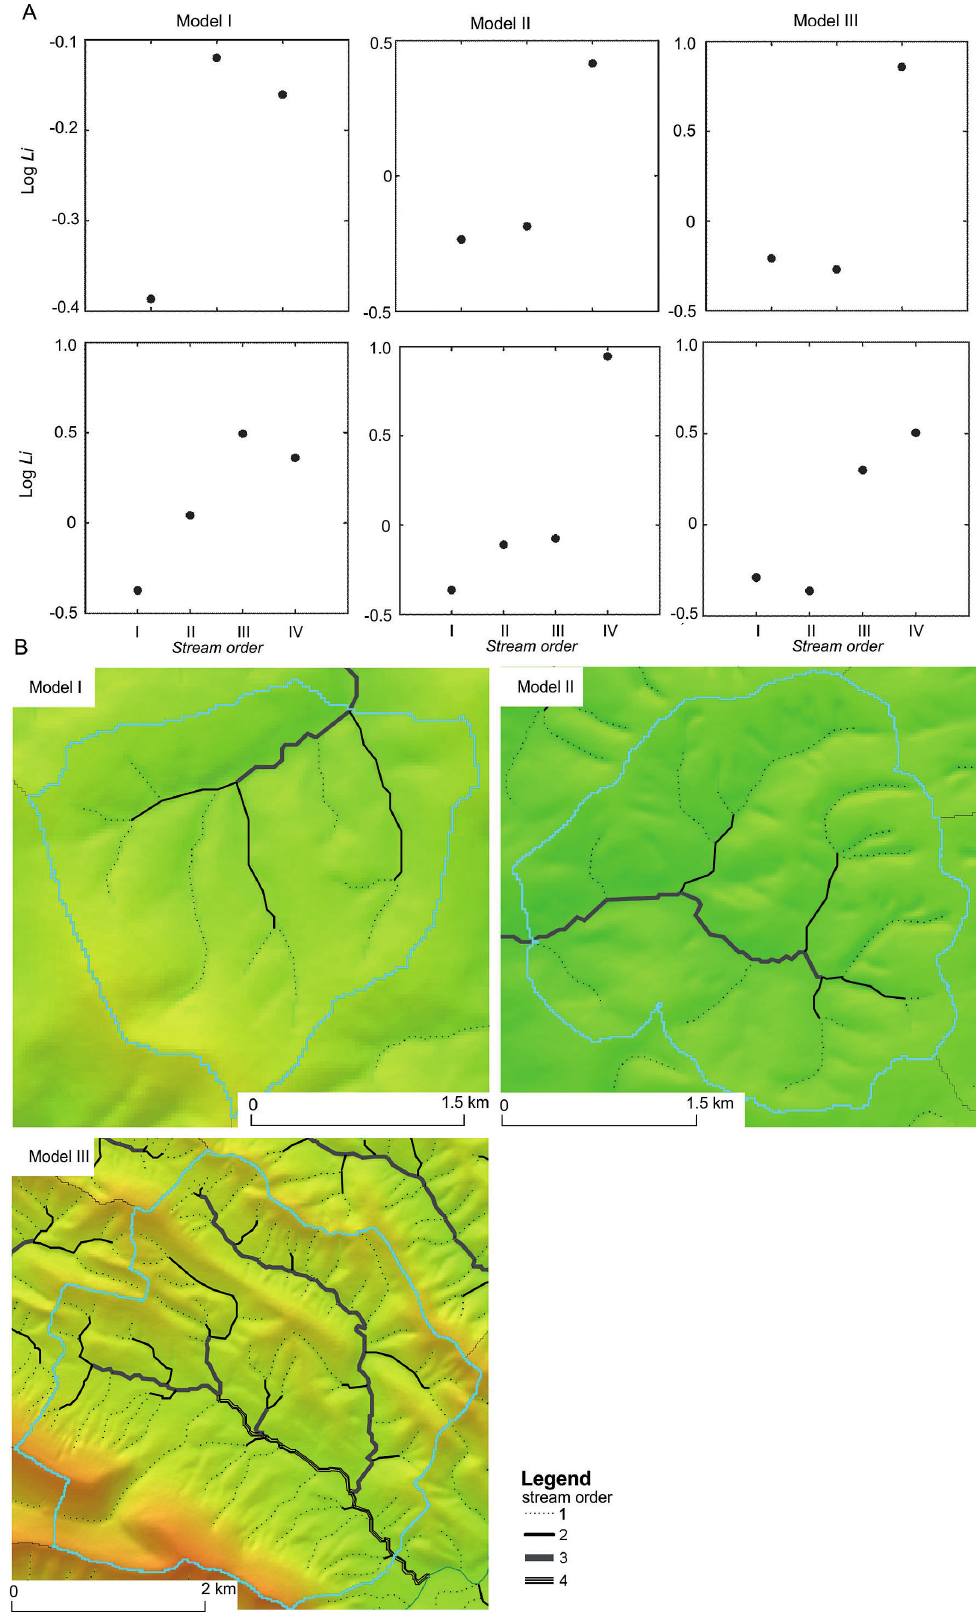
fig. 4. The models of a river system development in the catchments where the “law of stream length” was not fulfilled – A, Example catchments –